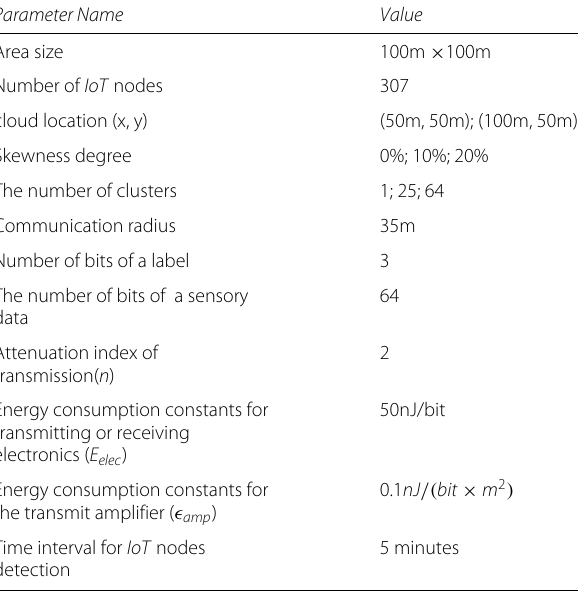
Factors affecting performance